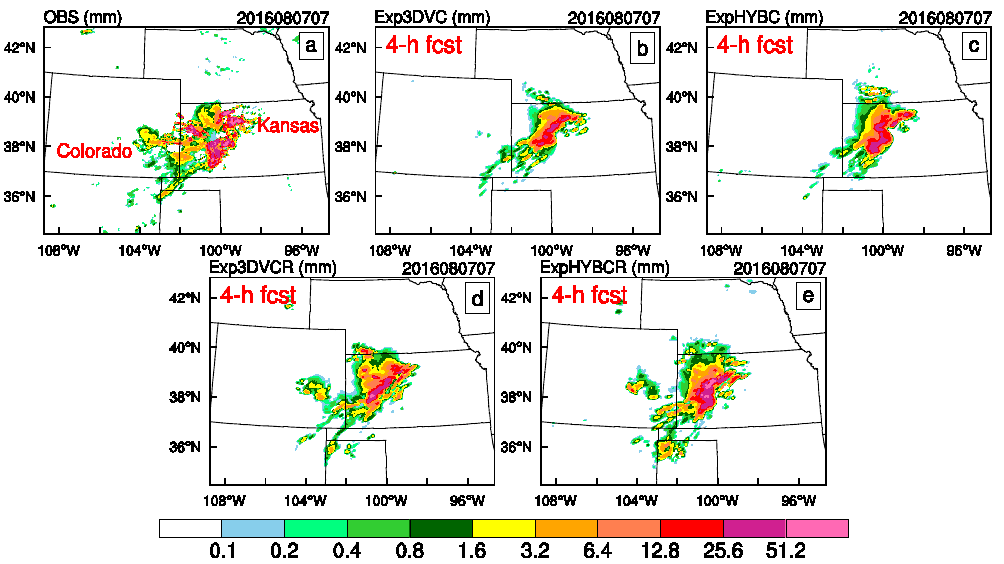
Figure 9. One-hour accumulated precipitation (unit: mm) of: observation ( a ); Exp3DVC ( b ); ExpHYBC ( c ); Exp3DVCR ( d ); and ExpHYBCR ( e ) of the convective system at 07:00 UTC on 7 August 2016 (initialized at 03:00 UTC on 7 August 2016). Atmosphere 2017 , 9 , x FOR PEER REVIEW